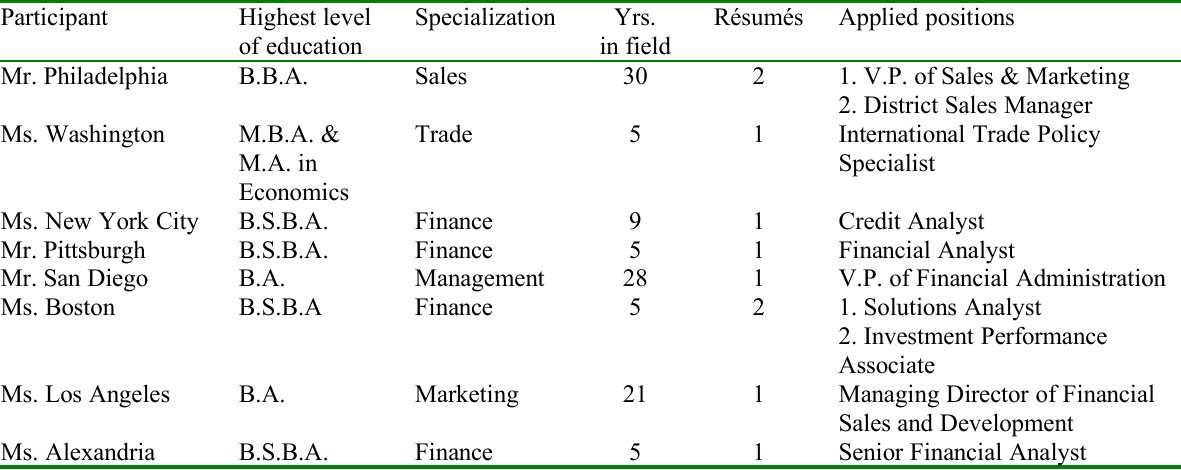
Participant Background